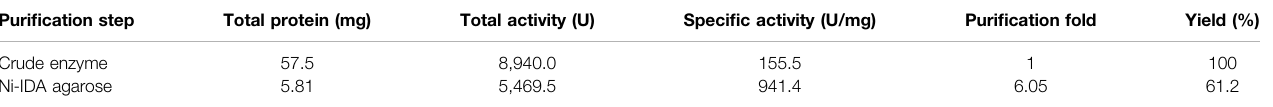
TABLE1 | Puri fi cation of tannase TanA.